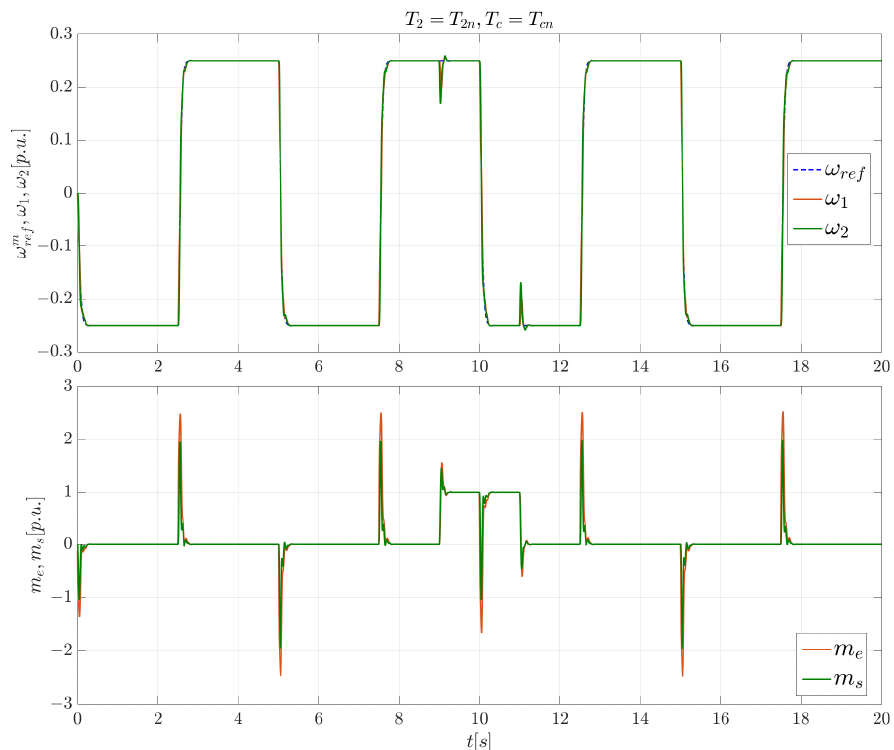
Figure 7. Speeds ( ω ref , ω 1 , and ω 2 ) and torques ( m e and m s )—transients for nominal parameters of drive.